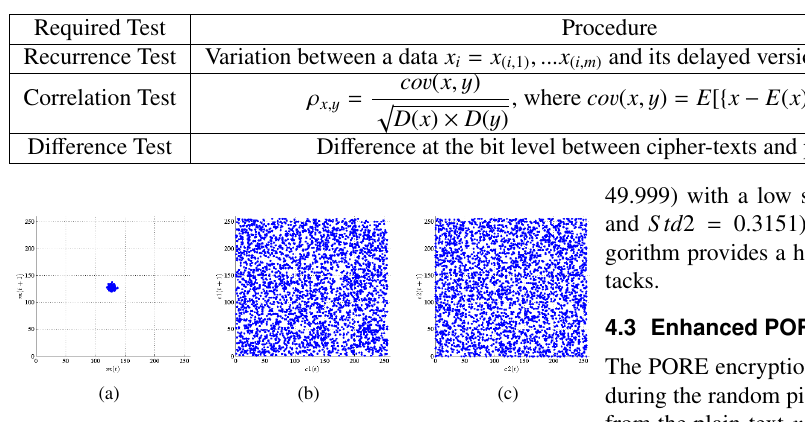
Figure 6: Recurence Test: (a)- Original message, (b)-Enh PORE Cipher 1 (c)-Enh Pore Cipher 2 with low standard deviations( Std 1 = 0 . 01779 and Std 2 = 0 . 01756), which means that the cipher-texts of the pro- posed algorithm do not reveal any information about the plain-texts.